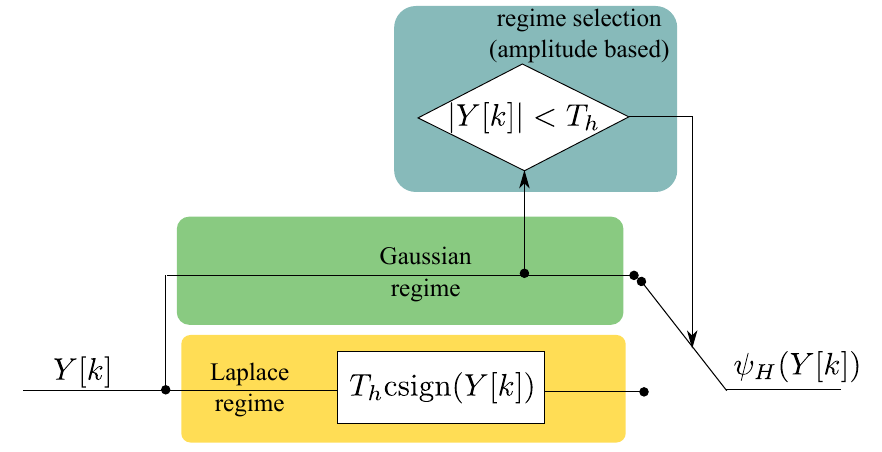
Figure 2. Processing implemented by Huber’s